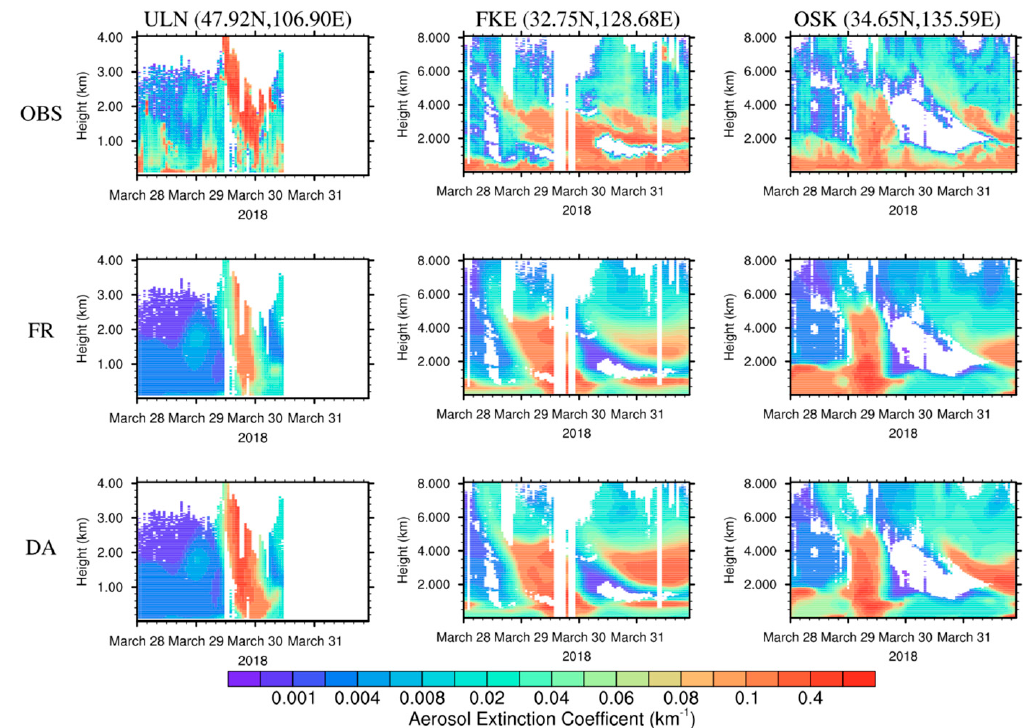
Figure 7. Comparisons of total observed aerosol extinction coefficients from AD-Net and simulated coefficients for FR and DA experiments from 28 to 31 March 2018 at three selected sites (ULN: Ulaanbaatar; FKE: Fukue; OSK: Osaka).